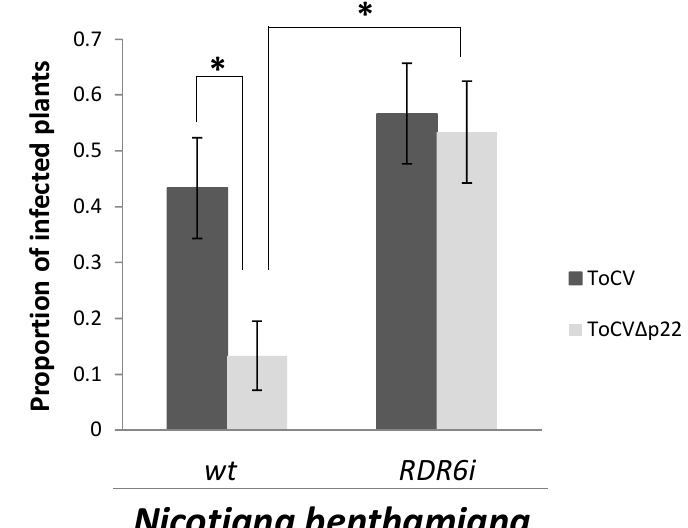
Figure 3. Systemic infection rate (mean ± standard error (SE)) of N. benthamiana wild-type and RDR6i plants inoculated with infectious clones of RNA1 of ToCV or ToCV Δ p22 and RNA2 of ToCV from two independent experiments. Infections of ToCV and ToCV Δ p22 were compared by the generalized mixed linear model with binomial error structure. For each genotype, infections with both viruses were compared by sequential Bonferroni tests. Bars represent the standard error of the mean, and asterisks indicate significant differences ( p < 0.05).